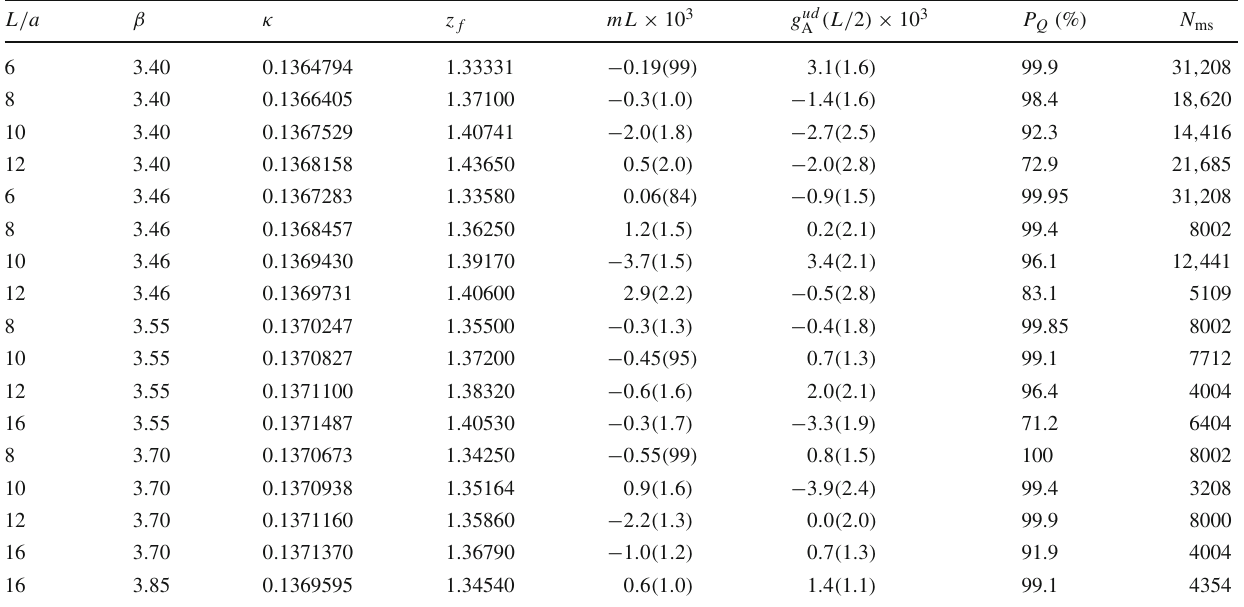
Table 9 Parameters of the N f = 3 ensembles and corresponding results for mL and g ud given by N ms ; these are spaced by 10 MDUs. In the table we also give the percentage P Q of gauge fields with Q = 0